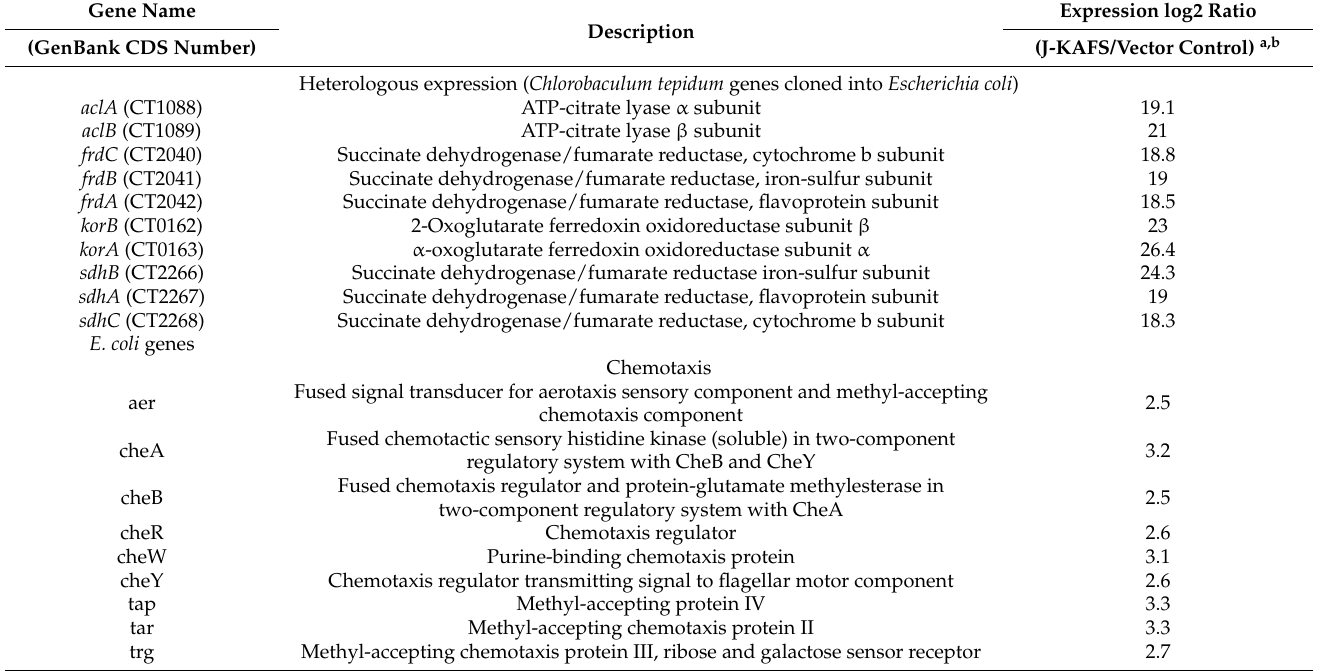
Table 4. Differential gene expression between J-KAFS and J-vector control strains under anaerobic respiration culture conditions.